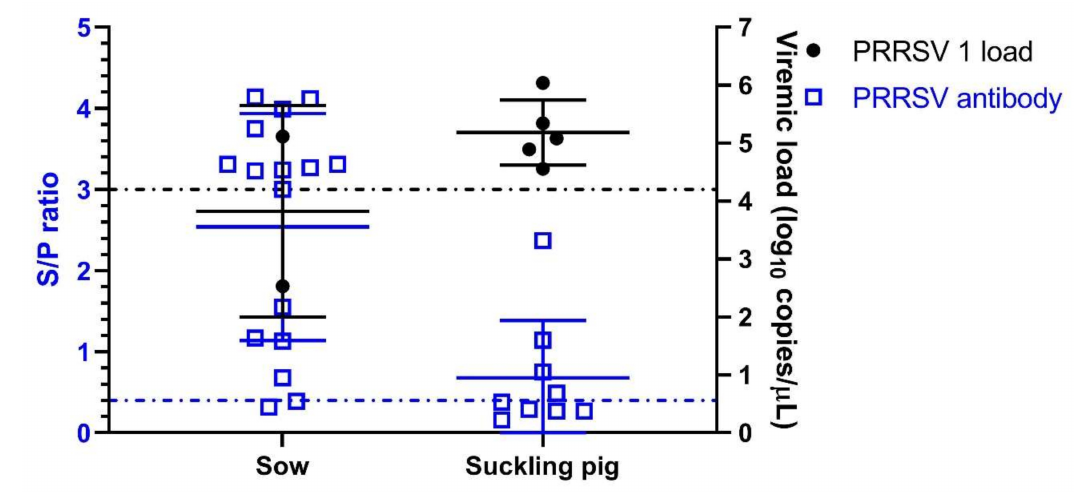
Figure 1. PRRSV 1 load and antibody level (sample-to-positive (S / P) ratio) of sows and suckling piglets su ff ered from porcine reproductive and respiratory syndrome (PRRS) in the present study.